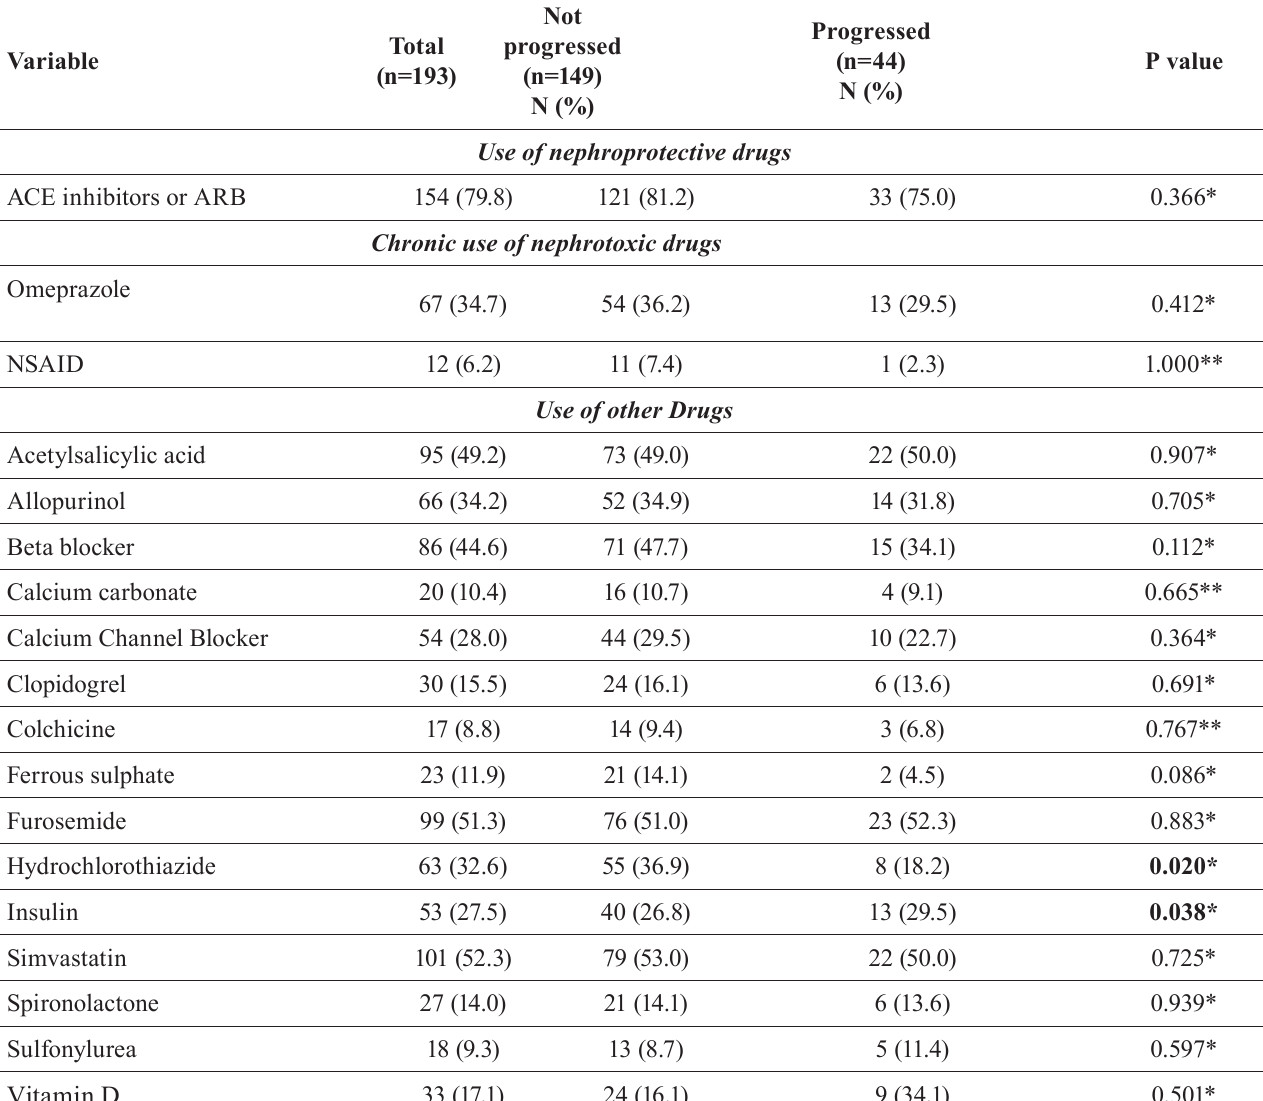
TABLE II - Use of nephroprotective, nephrotoxic, and other drugs more prevalent in patients with chronic kidney disease, attended between 2014 and 2016 at the Municipal Nephrology Ambulatory, in Divinópolis (MG), Brazil (n = 193)